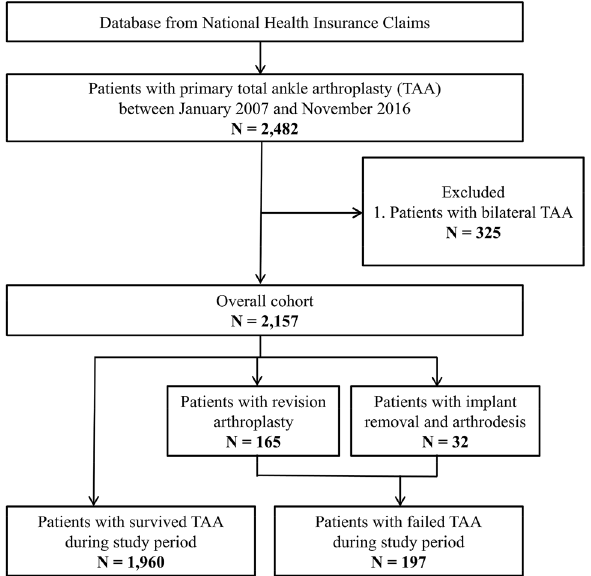
Figure 1. A schematic illustration of the participant selection process that was used in the present study. Out of a total of 2482 participants, 2,157 total ankle arthroplasty (TAA) participants were